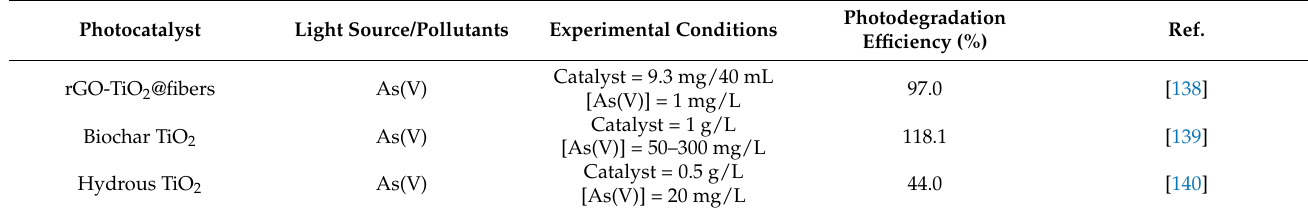
Table 6. TiO 2 -based photocatalyst for heavy metal